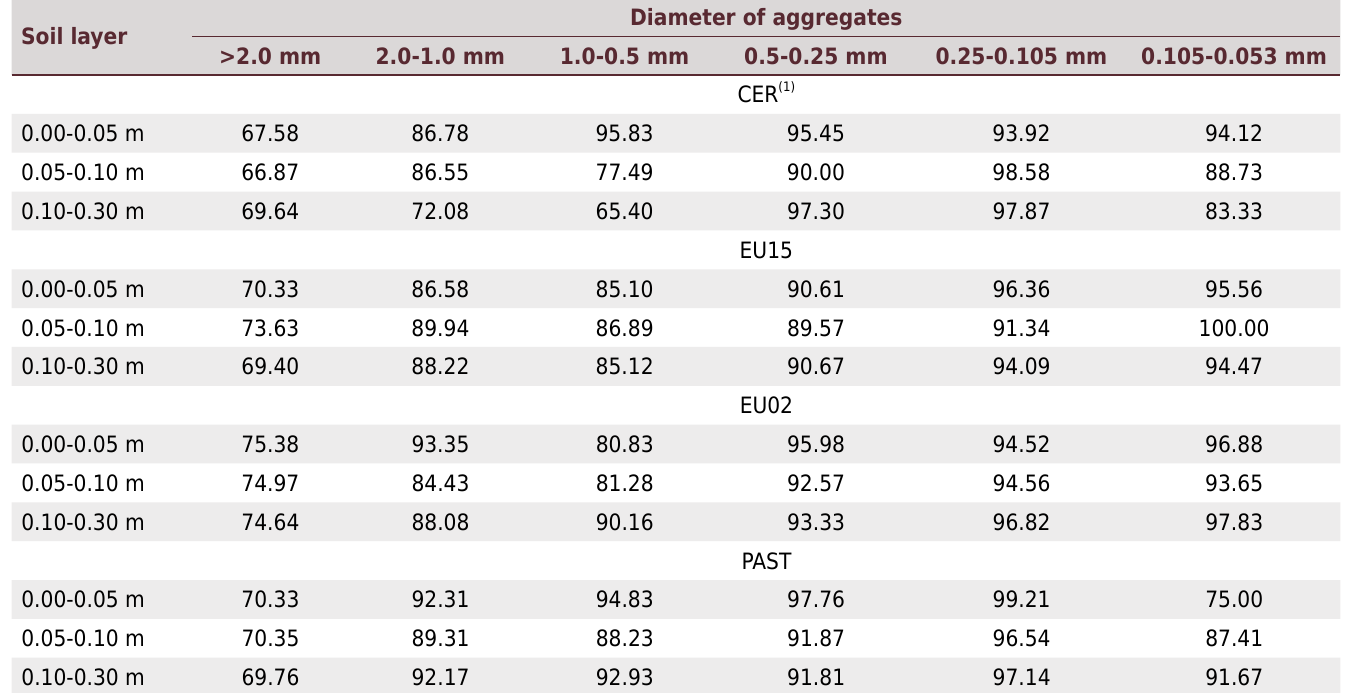
Table 6. Values of sand (%) present in the aggregates. according to land use (preserved Cerrado - CER, 15-year-old Eucalyptus - EU15, 2 year-old Eucalyptus - EU02, and Pasture - PAST) for the different soil layers and sand grain diameters Soil